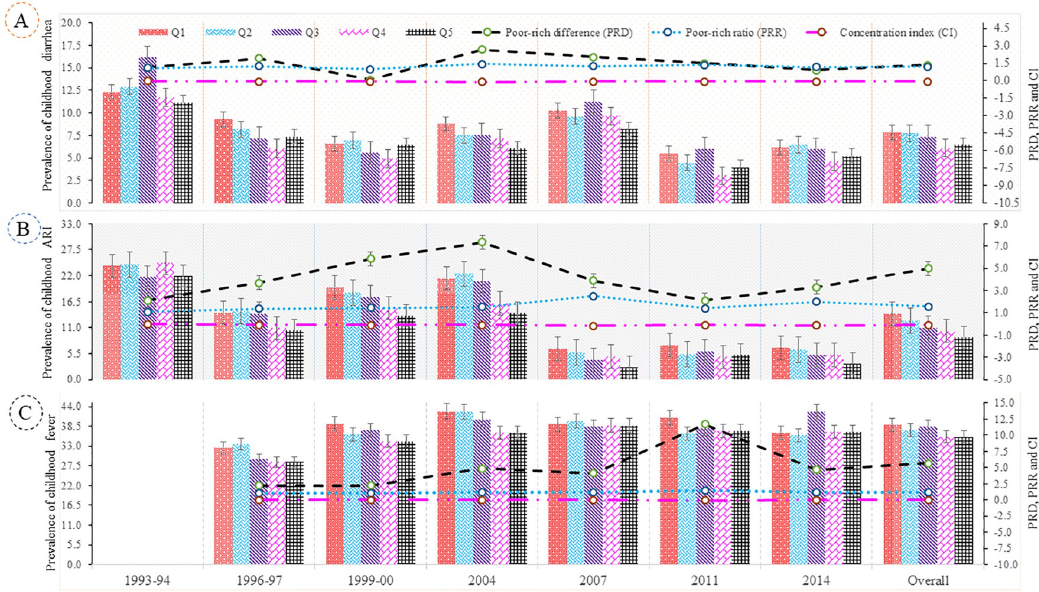
Fig 2. Distribution of childhood morbidity across scio-economic groups, 1993–2014. (A) Expressing the prevalence of childhood diarrhea and inequalities in terms of poor-rich difference (PRD), poor-rich ratio (PRR) and Erreygers’s concentration index (CI) (B) Presenting the prevalence of childhood acute respiratory infection (ARI) and inequalities in terms of PRD, PRR and CI (C) Showing the prevalence of childhood fever and inequalities in terms of PRD, PRR and CI.